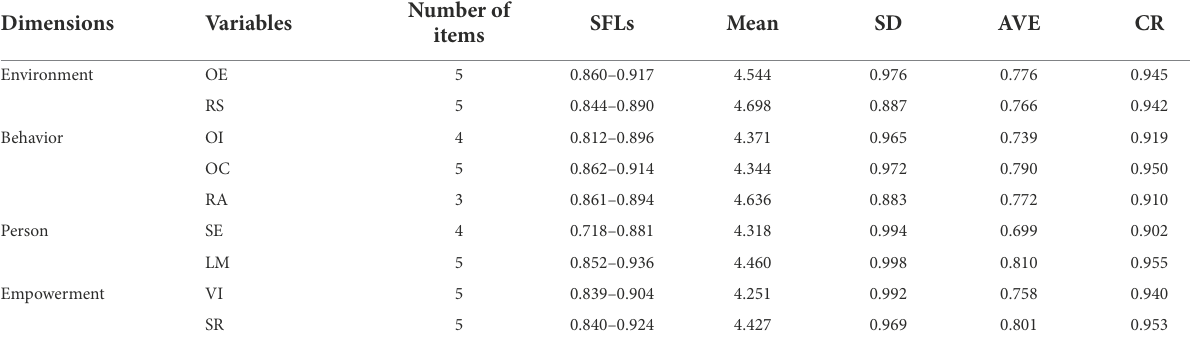
TABLE 1 Descriptive statistics and results of the measurement